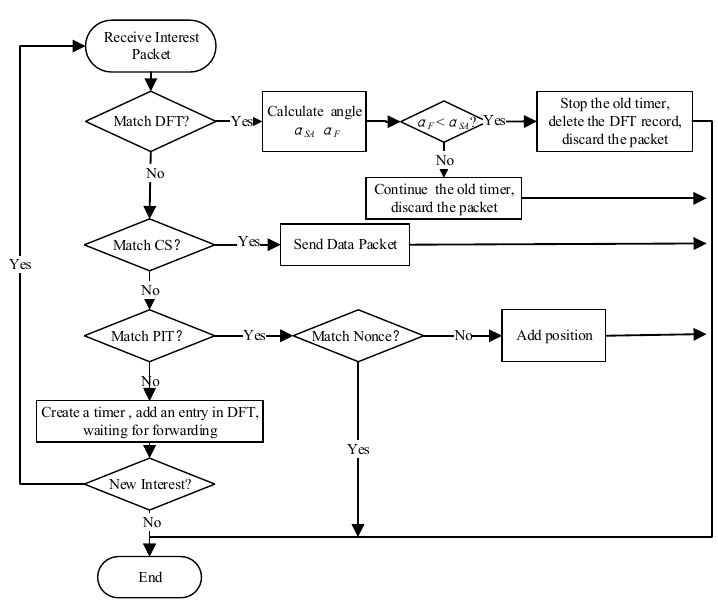
Figure 9. Forwarding control of Interest